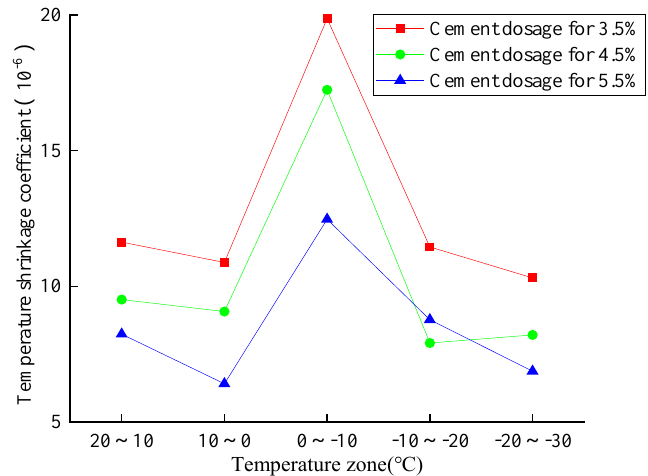
Figure 19. Analysis of the temperature shrinkage coefficient.